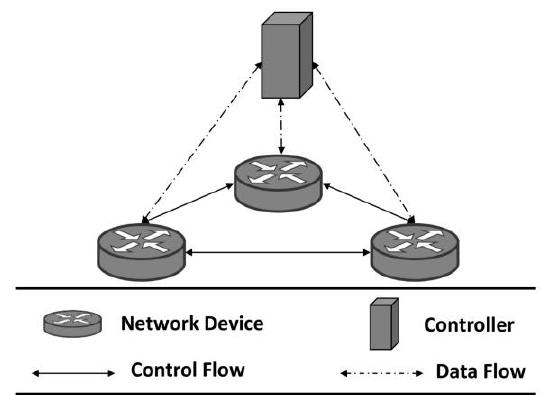
Figure 3. Centralized Controller Design .